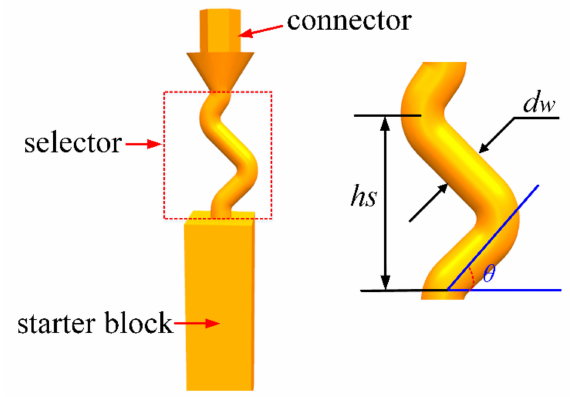
Figure 1. Schematic drawings of the Z-form 2D grain selector and its key geometric parameters. Table 1. The designed parameters of the take-o ff angle of di ff erent grain